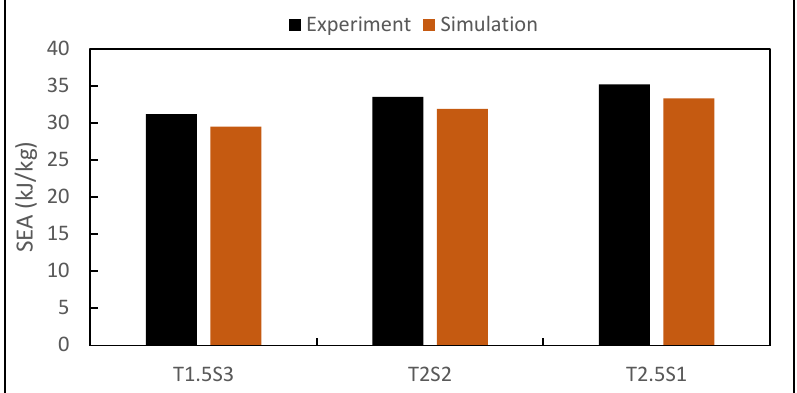
Figure 13. Comparison of experimental and simulated specific energy absorption (SEA) at 𝜀 = 0.60 .